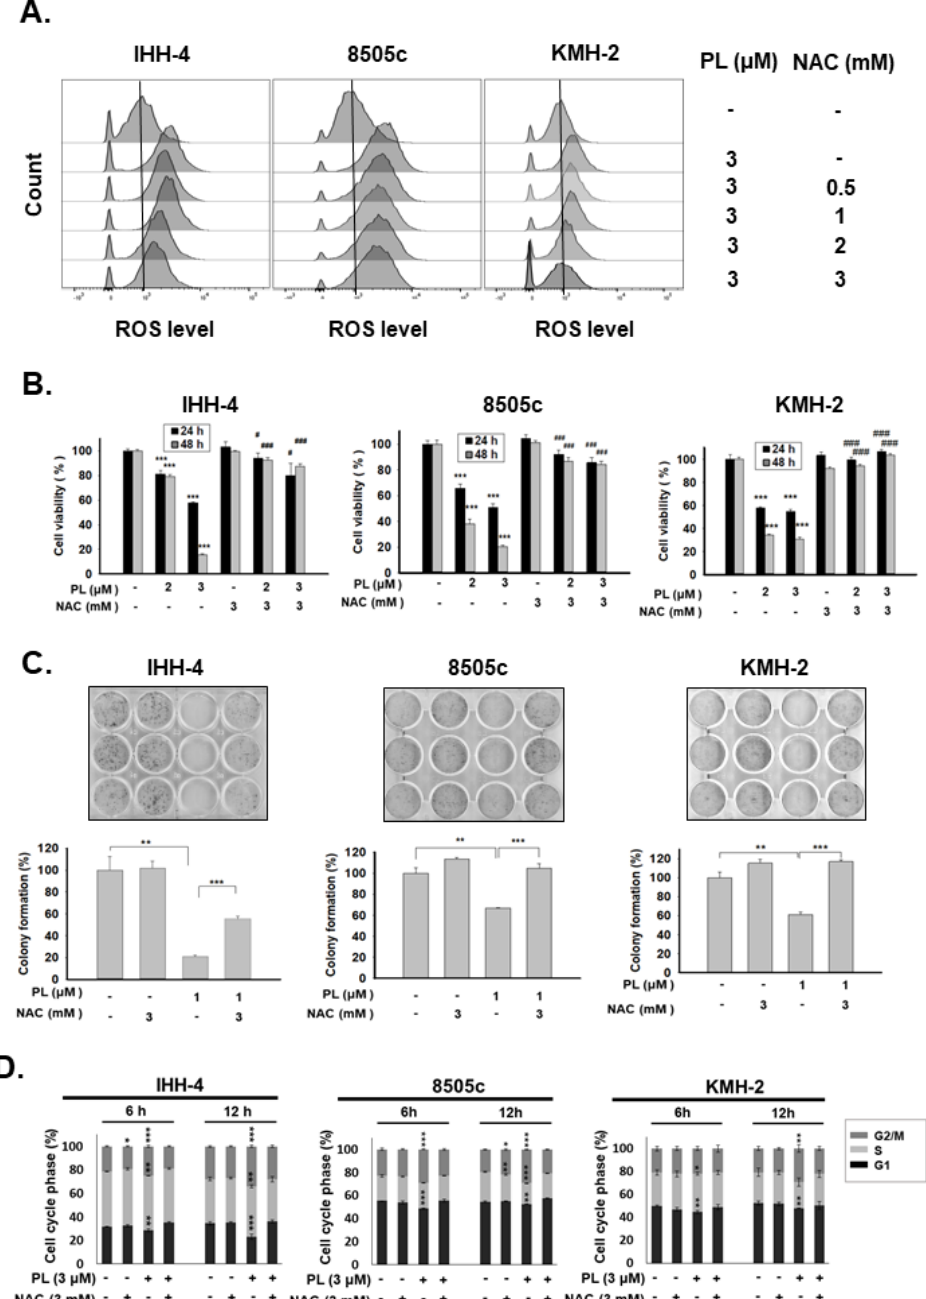
Figure 4. Modulation of cell growth, tumorigenesis, and cell cycle by piperlongumine (PL) by inducing reactive oxygen species (ROS) in human thyroid cancer cells. Three human thyroid cancer cells were incubated with PL, and NAC was used to inhibit ROS activation. ( A ) The expression of ROS was determined with fluorescence-activated cell sorting (FACS) flow cytometry. ( B ) Cellular viability and ( C ) colony formation were examined. ( D ) Cell cycle regulation was determined by FACS flow cytometry. Dimethyl sulfoxide (DMSO) was used as a negative control. ROS expression in ( A ) was confirmed with two independent experiments, and a representative experiment was shown. The cell viability, colony formation, and cell cycle were obtained in three independent experiments. * indicated comparing with the untreated group and # showed comparing with PL treated group. * and # indicates p < 0.05. ** indicates p < 0.01. *** and ### indicates p <